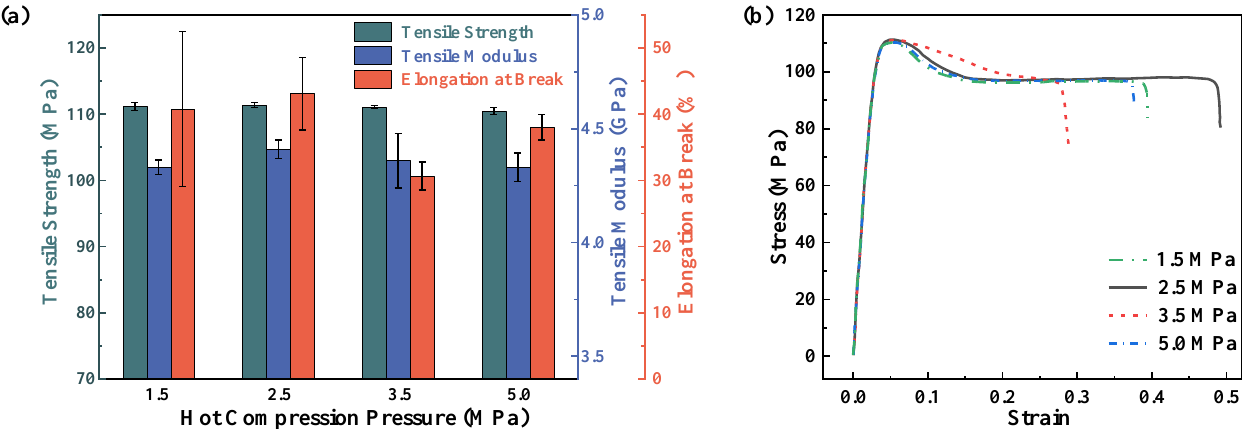
Figure 6. Tensile mechanical performance of PEEK plates under different hot compression pres- sures. ( a ) is the variety of different properties to pressure. ( b ) is the stress – strain relationship during tensile tests.